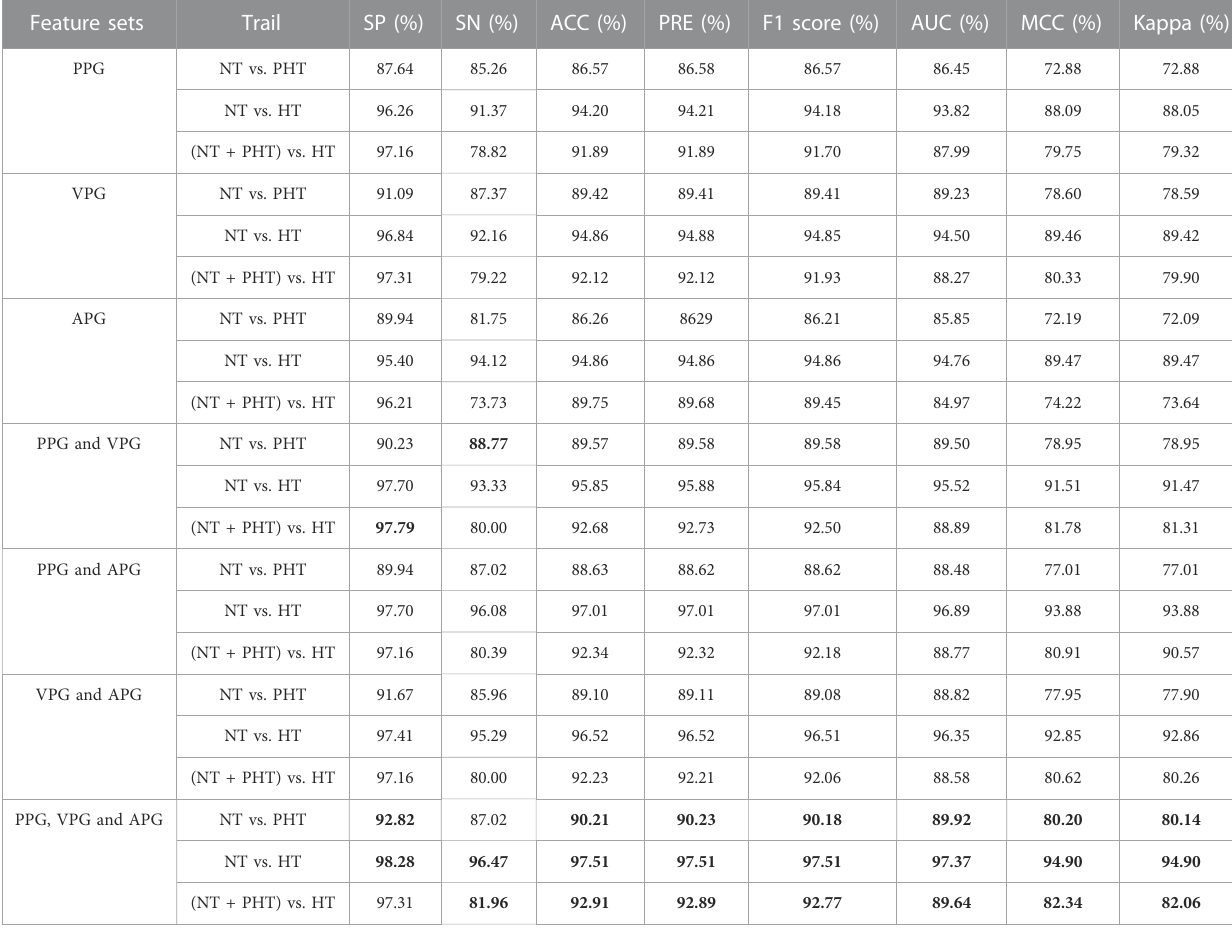
TABLE 3 Classi fi cation performance on different feature sets using Optuna-tuned LightGBM models. Note, NT, PHT, and HT denote normotension, prehypertension, and hypertension, respectively. PPG, VPG, and APG refer to photoplethysmography, velocity plethysmography, and acceleration plethysmography, respectively. SP stands for speci fi city, SN stands for sensitivity, ACC stands for accuracy, PRE stands for precision, MCC stands for Matthew ’ s correlation coef fi cient, Kappa stands for Cohen ’ s kappa coef fi cient, AUC stands for Area under curve. Values in Bold indicate highest scores achieved for each classi fi cation per evaluation metric.